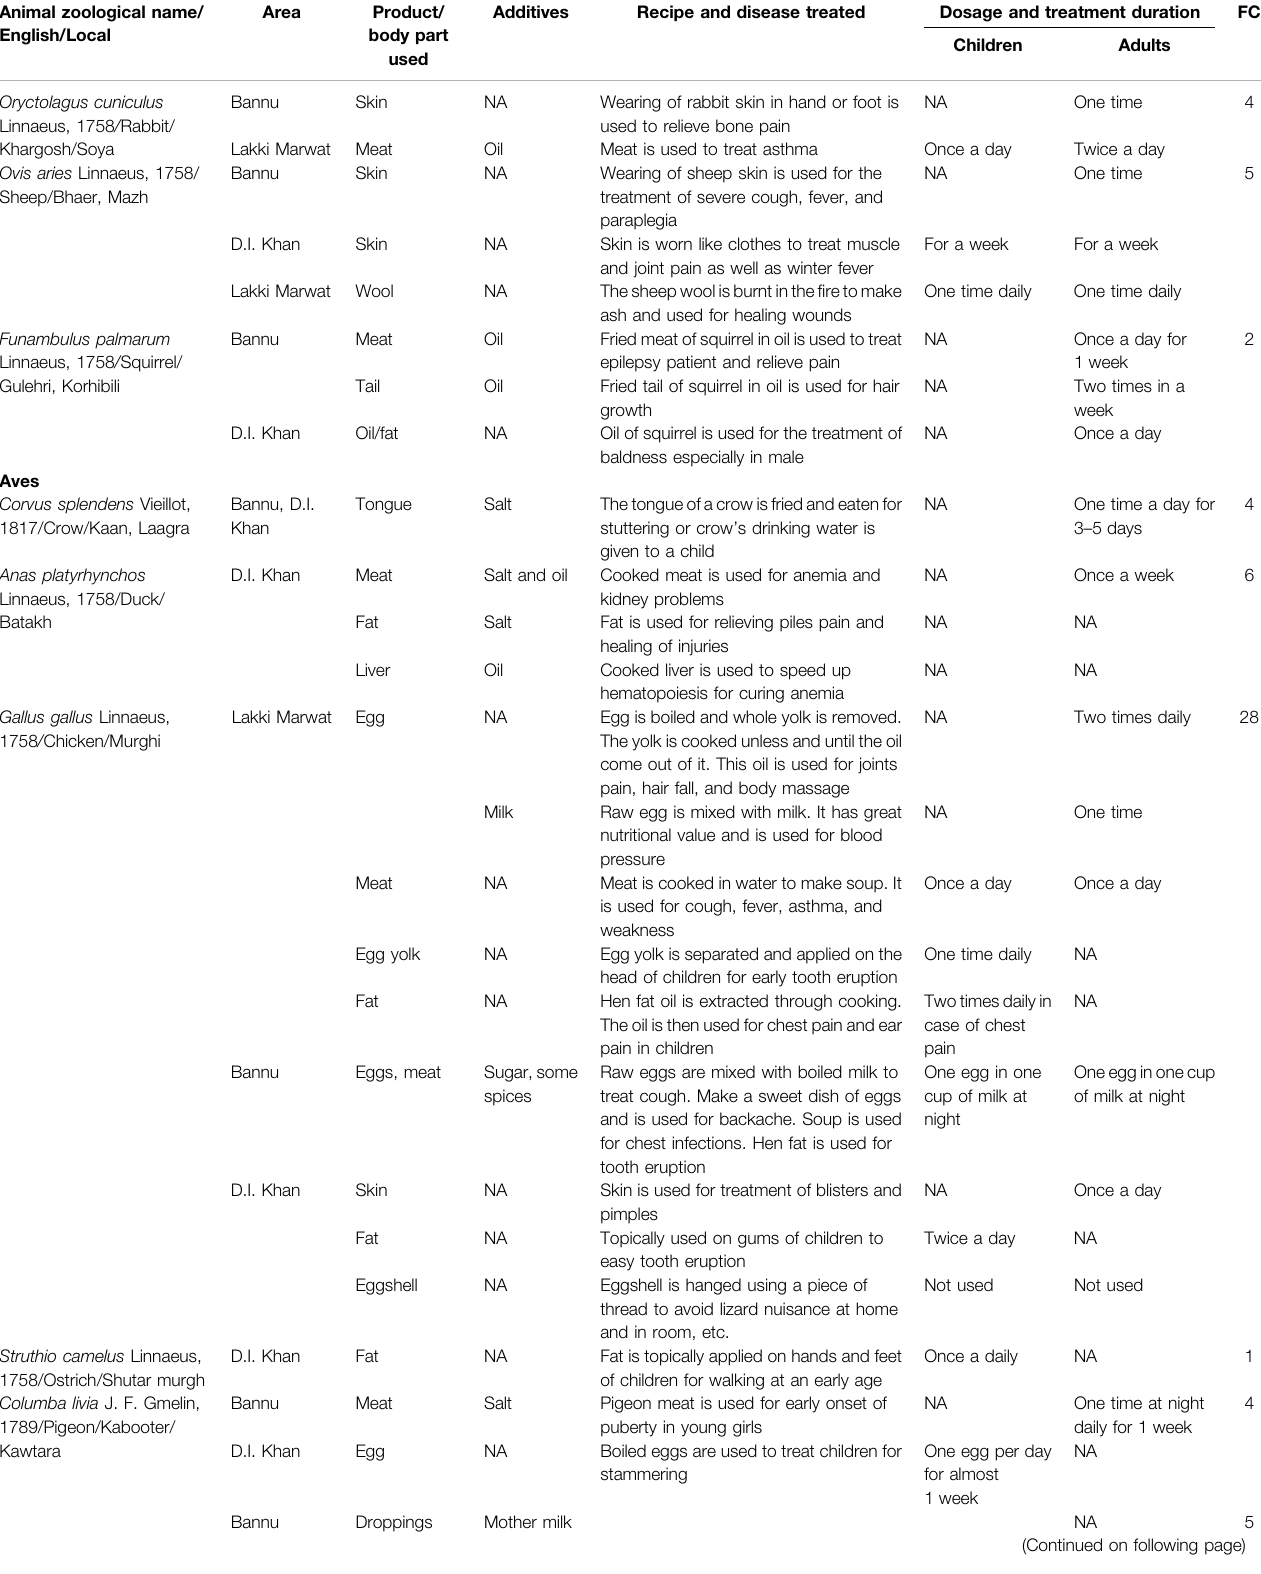
TABLE 2 | ( Continued ) Medicinal uses of animal species and their body parts/products in southern regions of Khyber Pakhtunkhwa (Pakistan). Animal zoological name/